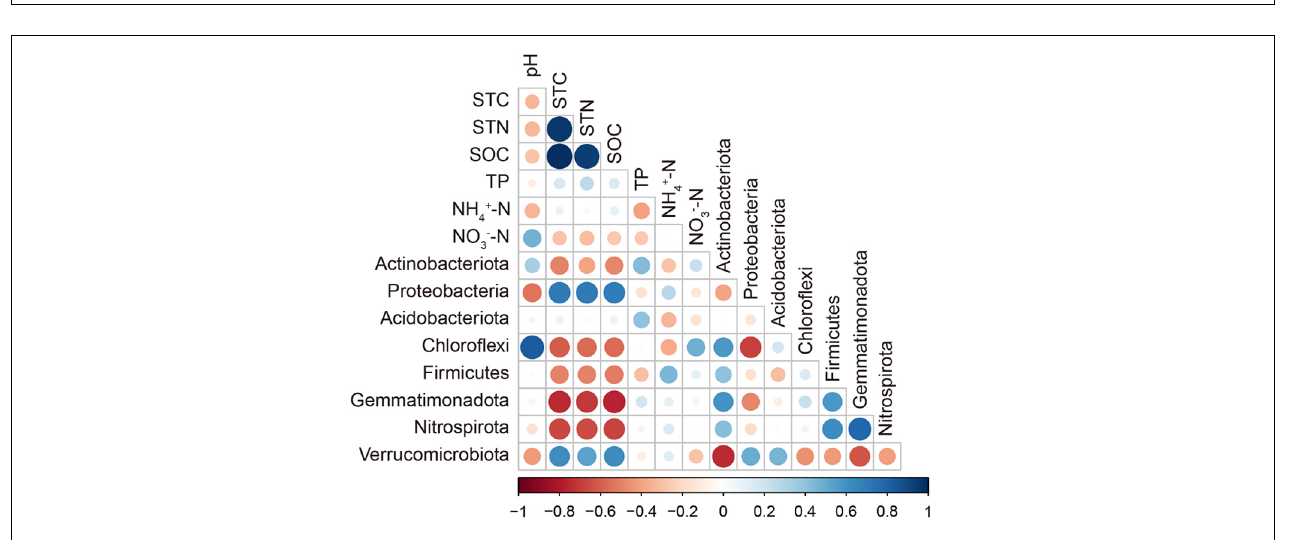
FIGURE 5 | Correlation between soil properties and the major bacterial phyla. Circle size and color represent the Pearson correlation coefficient.